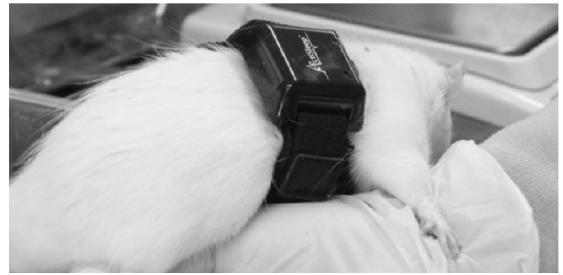
Figure 3. A representative picture of rat wearing the actigraph around its chest area.